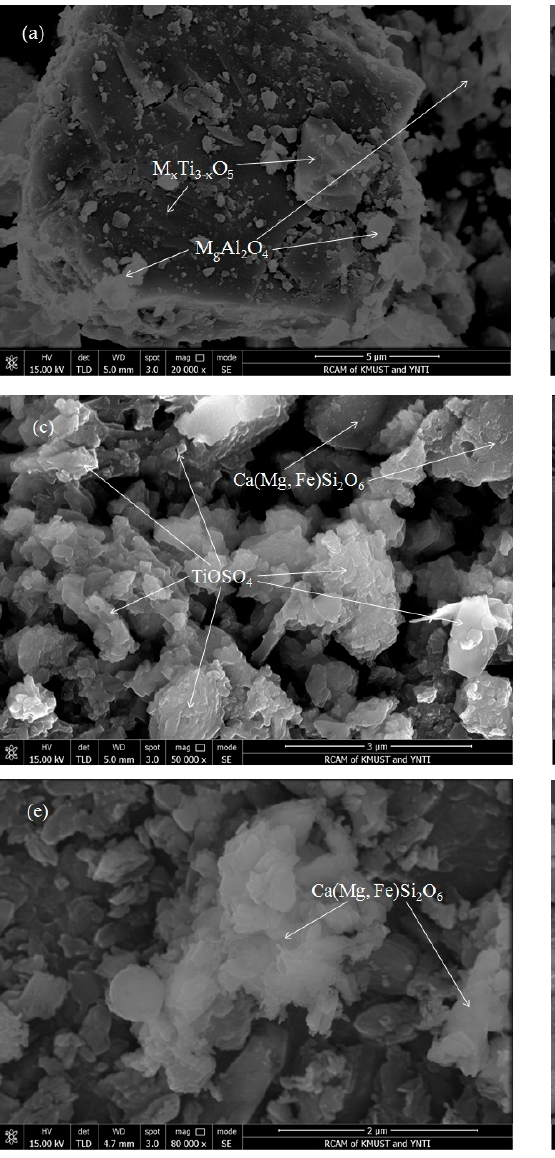
Figure 13. FESEM images showing the morphologies of original TEFS ( a , b ), acidolysis products ( c , d ), and water leaching residues ( e , f ).